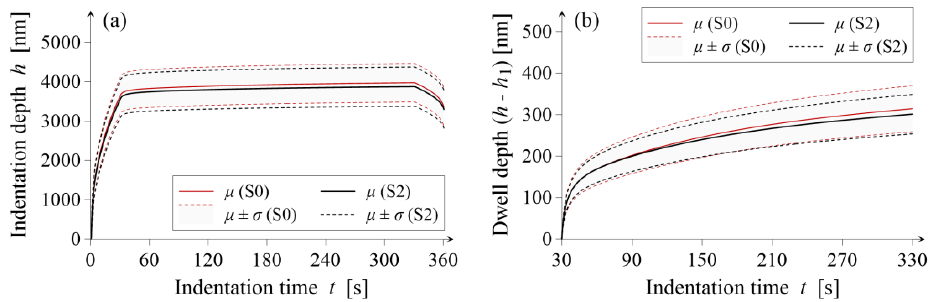
Figure 9. ( a ) Average indenter immersion during all the indentation phases and ( b ) average immersion in the creep phase only. Results for sample S1 versus the reference sample S0.